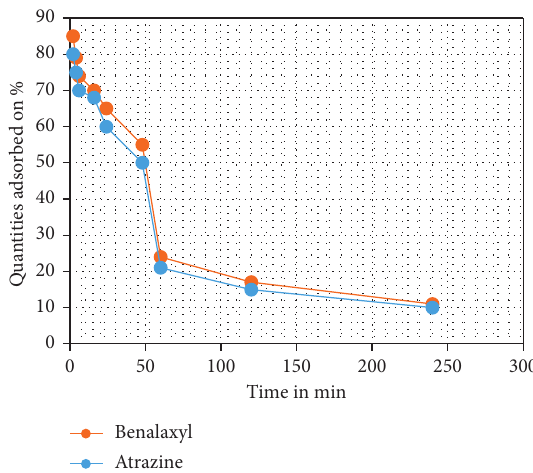
Figure 5: The % adsorbed amount of benalaxyl and atrazine in coal FAPP (Kosovo A) over